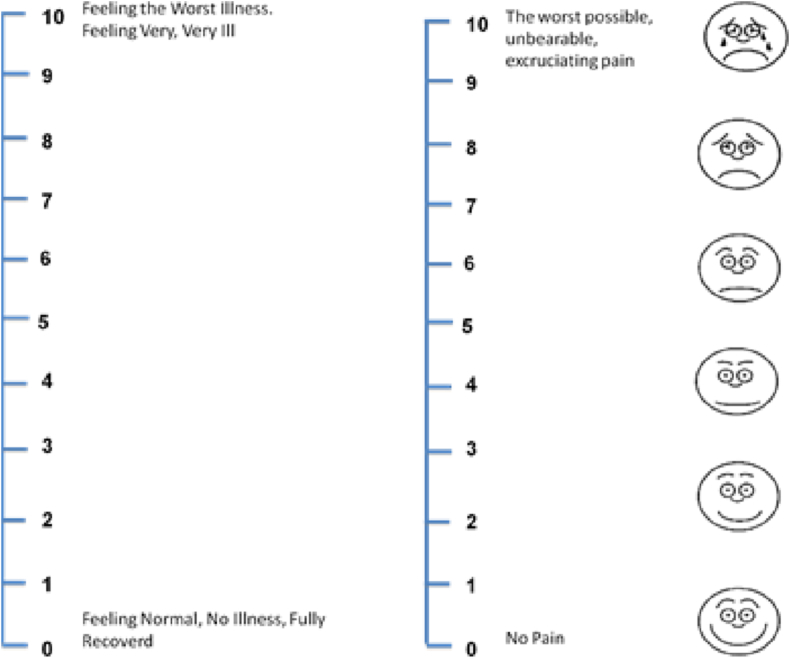
Ladder scales used to gauge severity of symptoms.